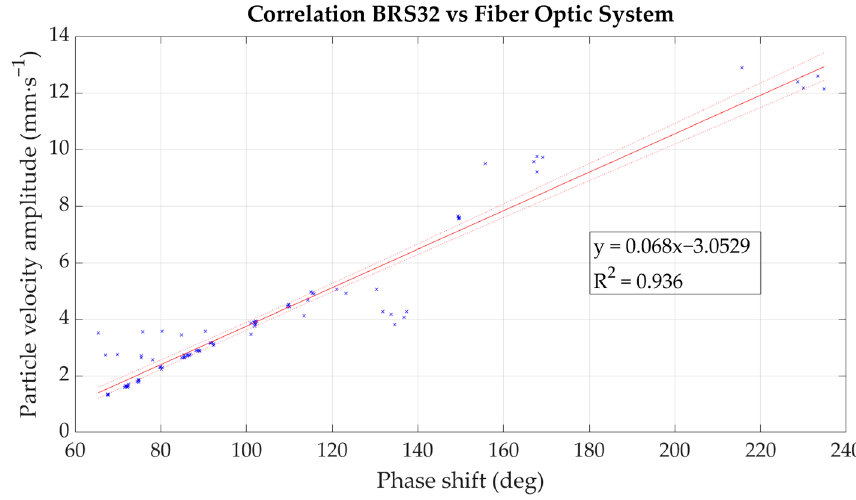
Figure 10. Mathematical dependence of the optical fiber system under development.